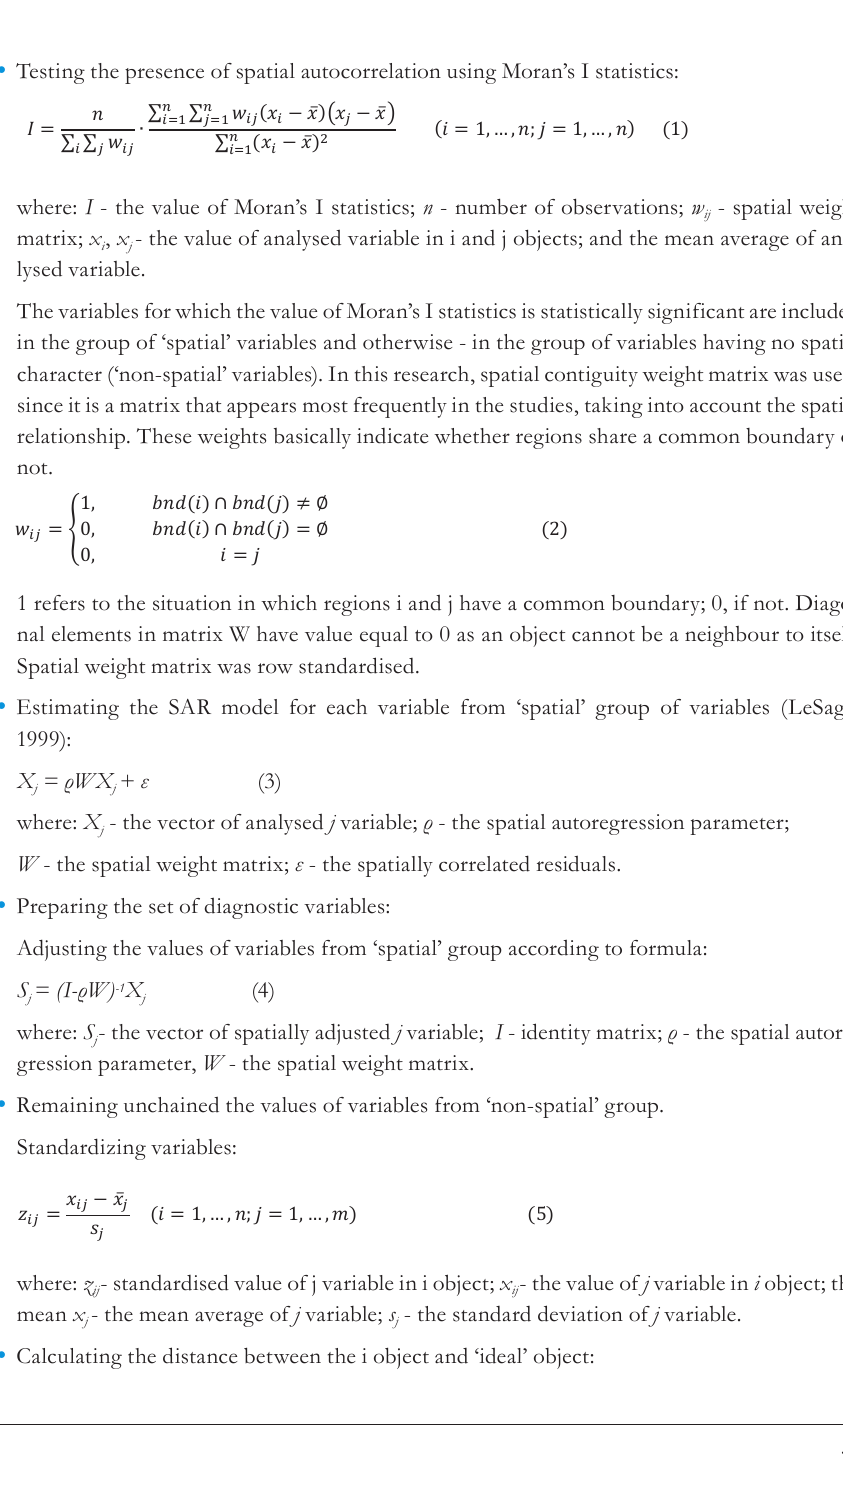
Testing the presence of spatial autocorrelation using Moran’s I statistics: